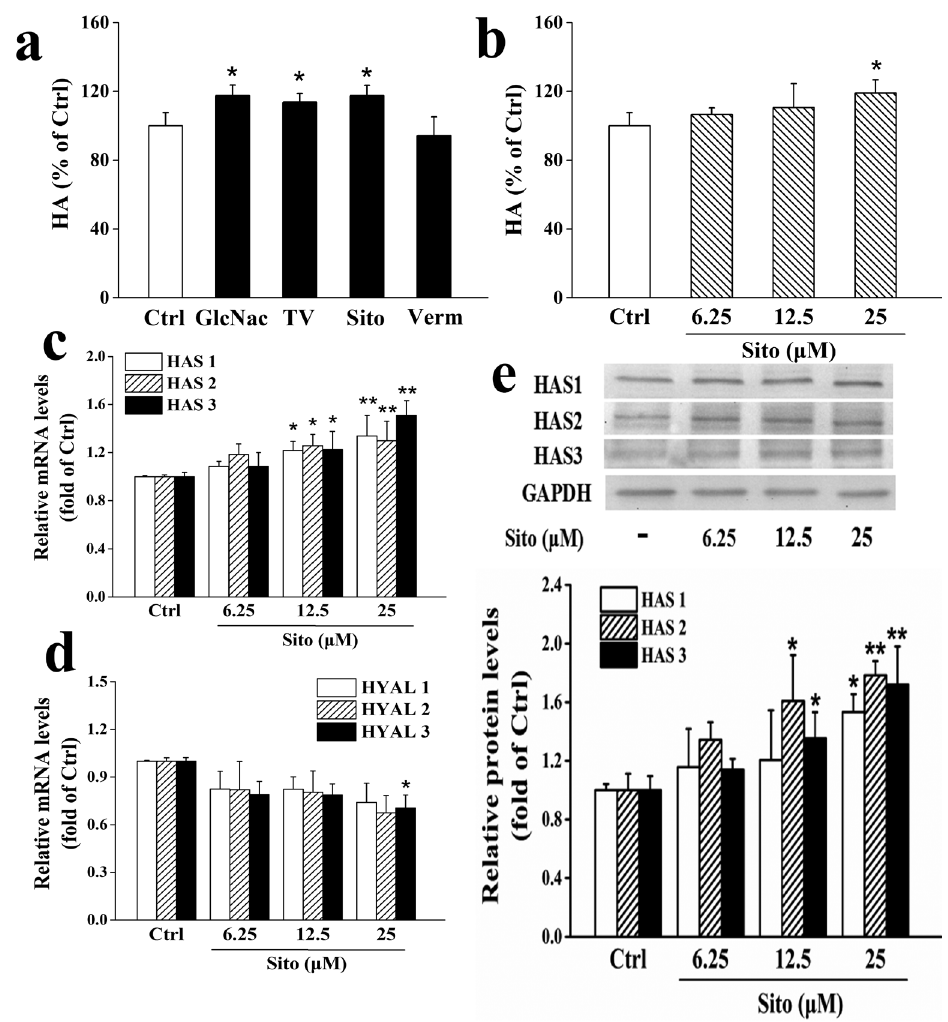
Figure 2 - Effects of compounds on HA content and on the expression of HASs and HYALs in HDF. Amount of HA ( a, b ) was measured by elISA kit. The mRNA expression of HAS1-3 ( c ) and HYAl1-3 ( d ) was measured by qRT-PCR. The protein expression of HAS1-3 ( e ) was measured by western blot. * P < 0.05 vs. Ctrl